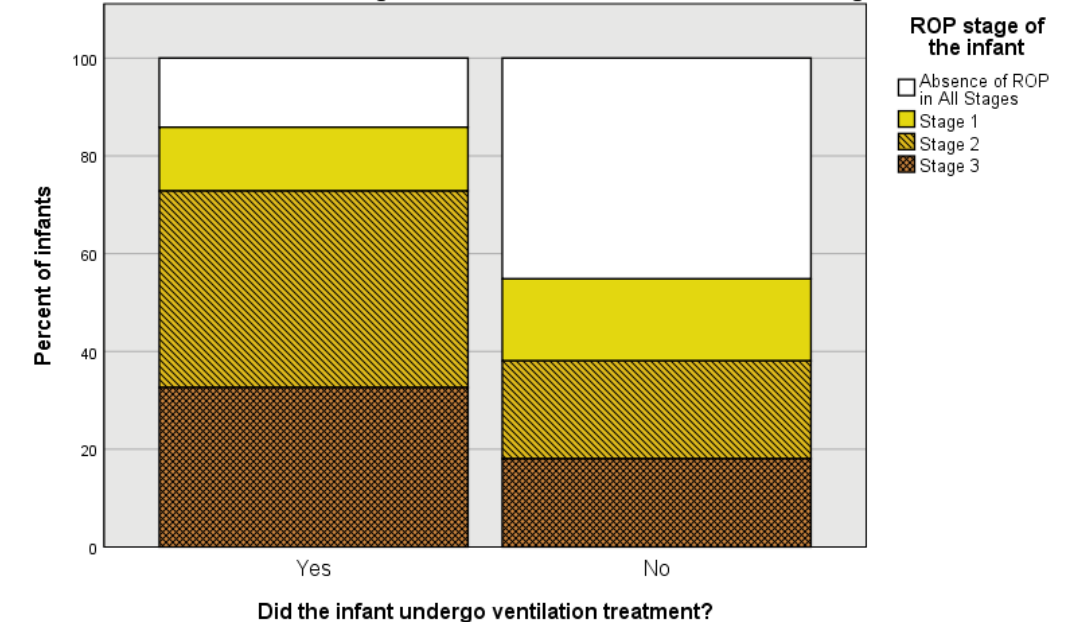
Figure 4. Percent incidence of various ROP stages for infants that underwent and did not undergo ventilation